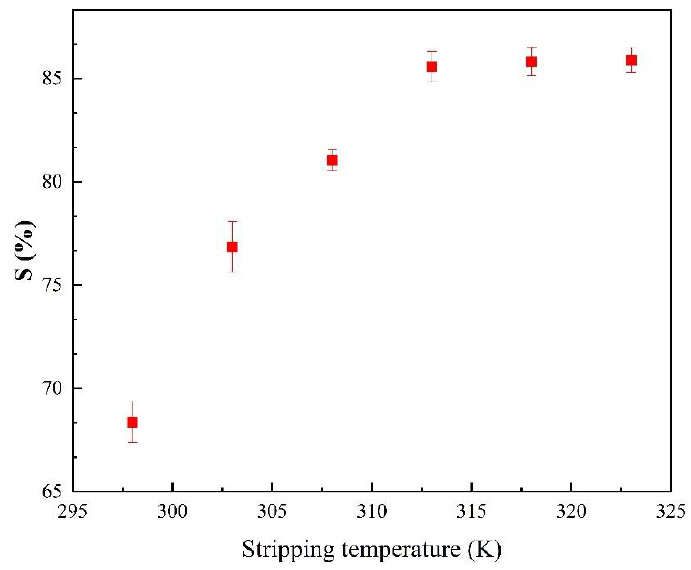
Figure 13. Effects of stripping temperature under the conditions: [oxalic acid] = 1 mol/L, stripping time = 40 min, and phase ratio = 1:1.